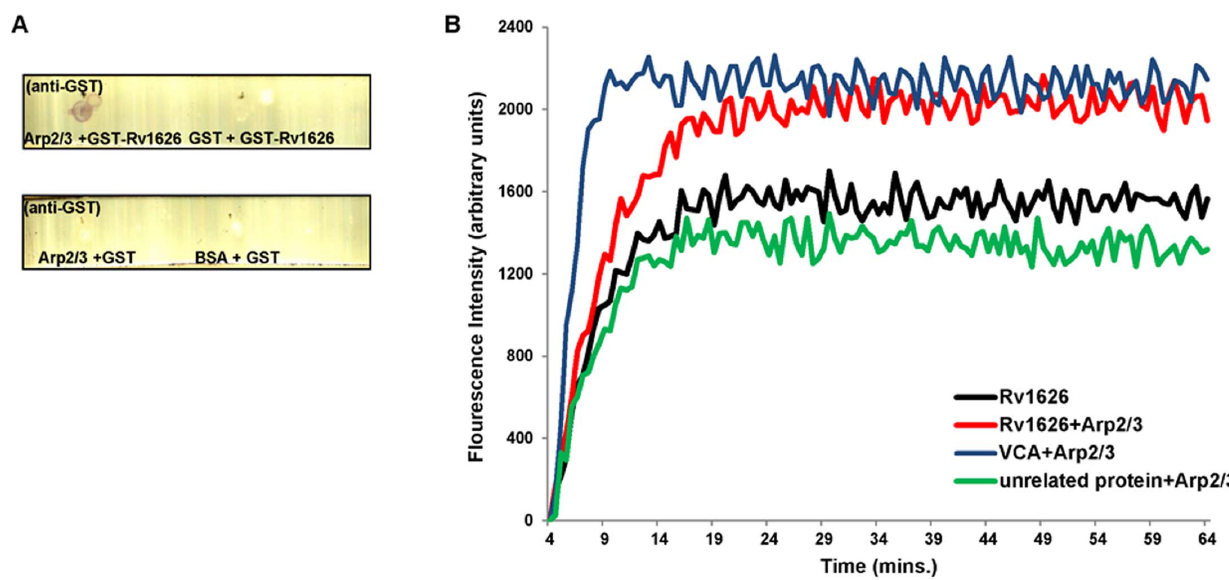
Figure 6. Rv1626-Arp2/3 protein-protein interaction. A. Dot Far-Western Blots showing in vitro protein-protein interaction between Arp2/3 and Rv1626. 1 m g each of Arp2/3 and BSA proteins were immobilized and the strips incubated overnight in 1 m g/mL solution of the either GST- Rv1626 or GST protein followed by development using anti-GST antibody. B. Rv1626 interaction with Arp2/3 enhances Actin Polymerization. Polymerization of G-actin to F-actin leads to an increase in the fluorescence intensity of pyrene-labelled actin, plotted here as a function of time. The figure shows the effect of Rv1626 protein on the rate of actin polymerization. Rv1626 (500 nM alone, black); Arp2/3 (10 nM) in the presence of Rv1626 (500 nM, red), VCA domain (400 nM, blue), and an unrelated protein (500 nM,